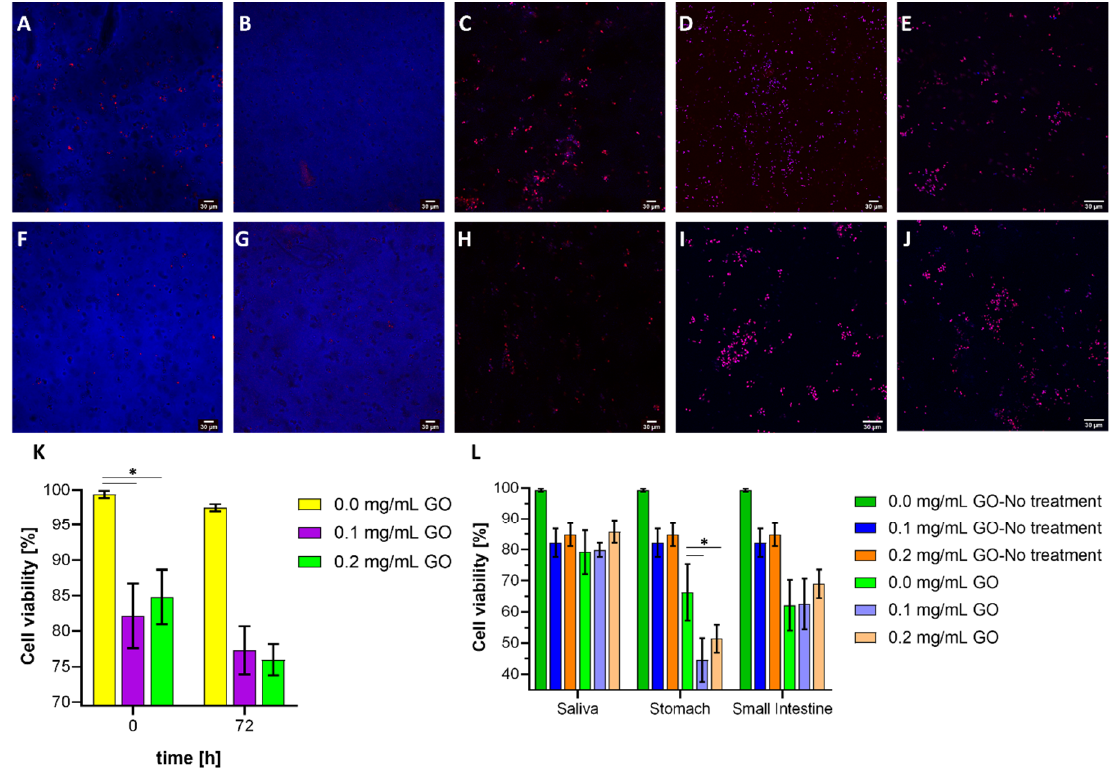
Figure 8. Confocal microscopy images. Dead cells are shown in red color while live cells in blue. Scale bar corresponds to 30 µ m. Live/dead K. lactis cells in the encapsulates made with 0.1 mg/mL GO at the beginning ( A ), after 72 h of bioreactor operation ( B ), after exposure to simulated saliva medium ( C ), after exposure to simulated stomach medium ( D ), and after exposure to the simulated small intestine medium ( E ). Live/dead K. lactis cells in the encapsulates made with 0.2 mg/mL GO at the beginning ( F ), after 72 h of bioreactor operation ( G ), after exposure to simulated saliva medium ( H ), after exposure to simulated stomach medium ( I ), and after exposure to the simulated small intestine medium ( J ). Yeast probiotic cell survival rate for encapsulates before and after bioreactor operation ( K ) and after treatment with each of the gastrointestinal tract simulated media ( L ). *, p <0.05.